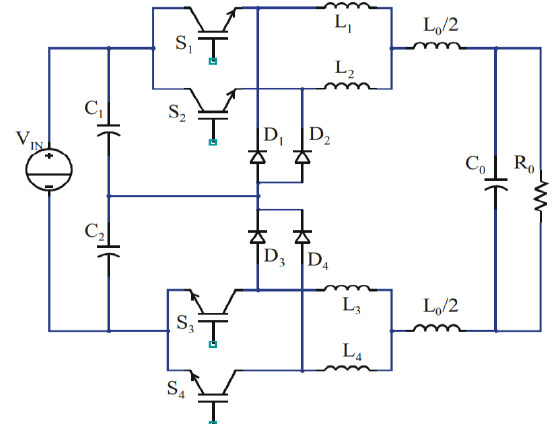
Fig. 6. Interleaved zero current transition (ZCT) three-level (TL) buck converter [11].